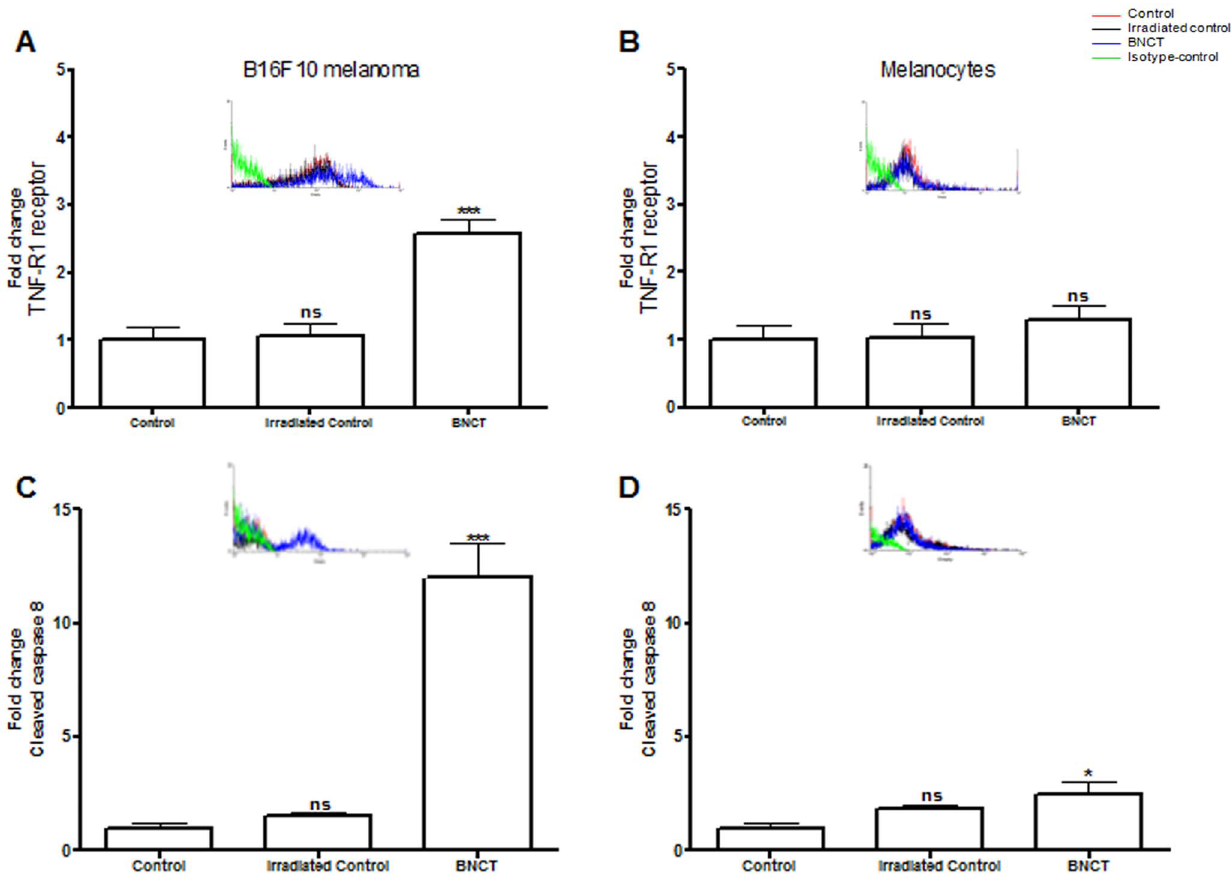
Figure 5. Expression of extrinsic apoptotic markers in B16F10 melanoma cells and normal melanocytes (mean 6 s.d.) determined by flow cytometry. (A) Expression of TNF-R1 in B16F10 melanoma cells after BNCT treatment and neutron irradiation alone (irradiated control) compared to cells without any treatment (control). (B)Expression of TNF-R1 in normal melanocytes after BNCT treatment and neutron irradiation alone (irradiated control) compared to cells without any treatment (control). (C) Expression of cleaved caspase 8 in B16F10 melanoma cells after BNCT treatment and neutron irradiation alone (irradiated control) compared to cells without any treatment (control). (D)Expression of cleaved caspase 8 in normal melanocytes after BNCT treatment and neutron irradiation alone (irradiated control) compared to cells without any treatment (control). Cells incubated with FITC-conjugated isotype-specific antibodies were used as negative controls. ns: not significant compared to control. *p , 0.05; **p , 0.01; ***p , 0.001 compared to